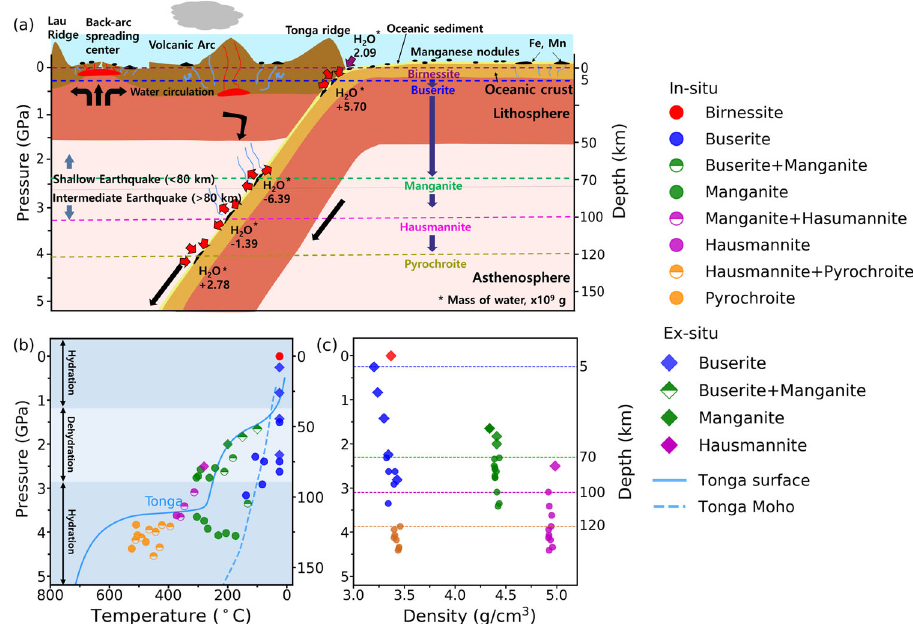
Fig. 4 A proposed water transportation scheme by manganese oxide minerals along an aqueous cold subducting slab. a A schematic illustration of subducting birnessite to show the associated water transportation via super-hydration and subsequent transformations in the Tonga region. Mass of water is an uptake ( + ) from or release ( − ) into the surroundings (Supplementary Table 5). b Observed phase stabilities of manganese oxide minerals along the Tonga subduction geotherm following the model by Syracuse et al. 24 . c Depth-dependent changes in the crystal density (g/cm 3 ) of manganese oxide minerals observed in our